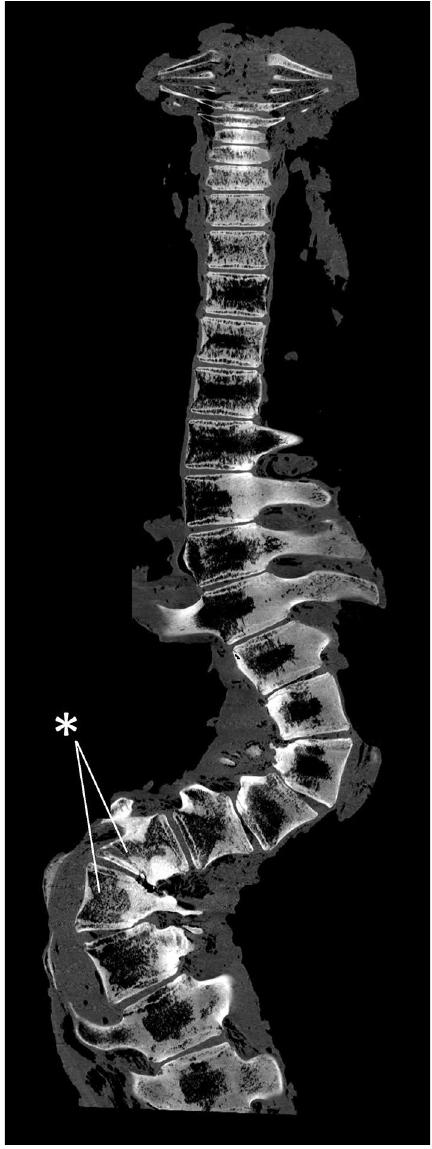
Figure 4. Dorsal view with the cranial side upwards from the CT-scan of level C1 to L7. The site of the blunt traumatic injury at level L3/L4 (indicated with an asterisk) initiated a double compensatory curve cranially and a single compensatory curve